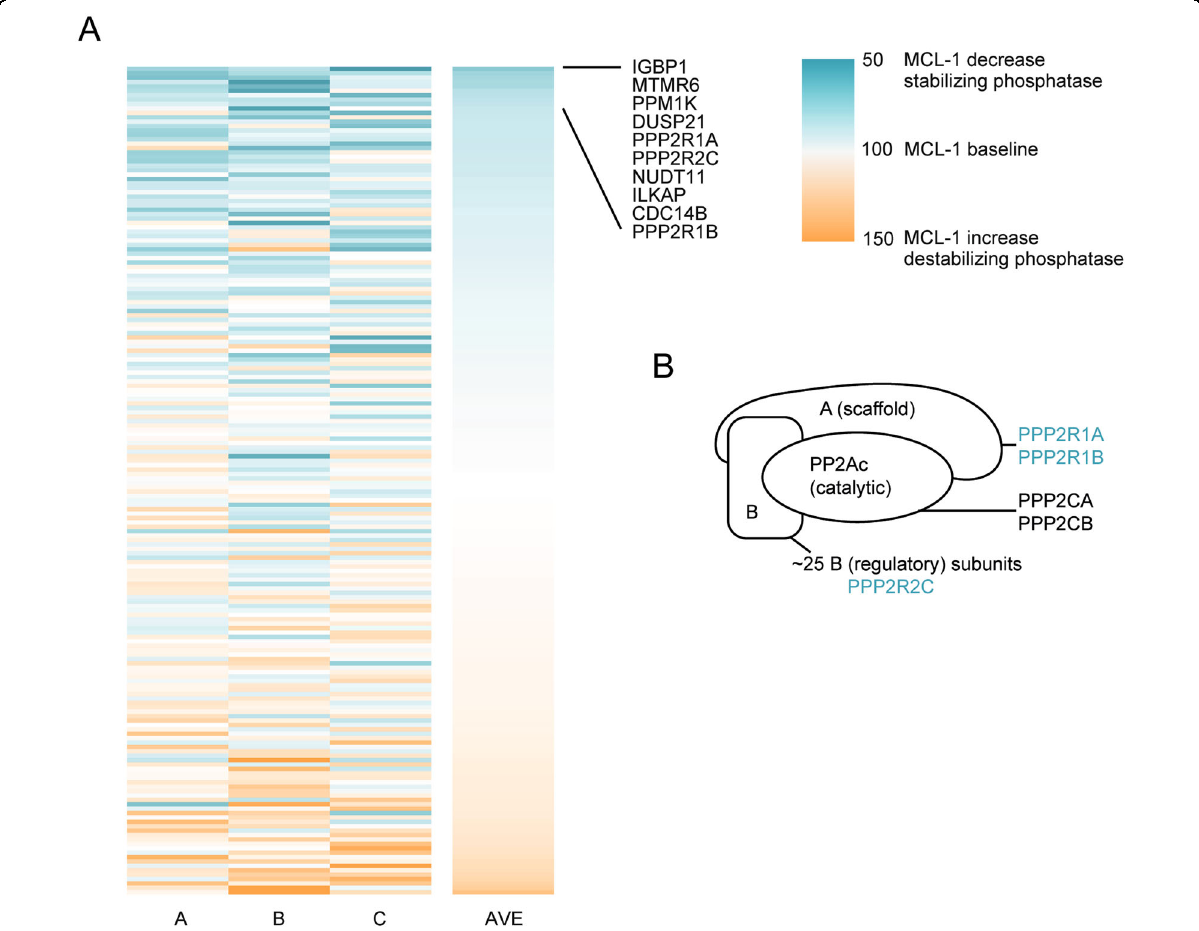
Fig. 3 Phosphatase siRNA screen identi fi es PP2A as MCL-1 stabilizing phosphatase. A Heatmap indicates changes in the MCL-1 level after phosphatase knockdown ( t = 66 h). The phosphatase siRNA screen was performed in three independent replicates (named A, B, or C), after which the 188 included siRNA pools were ranked based on average MCL-1 expression (AVE). The top 10 hits are named in the fi gure. B Schematic presentation of the three subunits of PP2A, with subunits that were identi fi ed in the phosphatase screen shown in